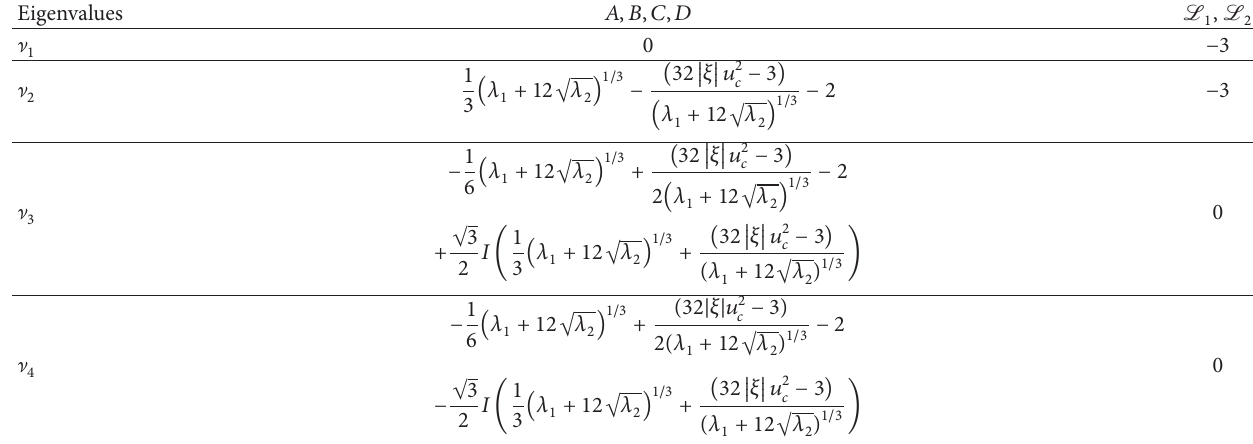
Table 2: The eigenvalues of the linearization matrices corresponding to the critical points and lines in Table 1. Here, 𝜆 1 = 216|𝜉|𝑢 2 𝑐 + 27